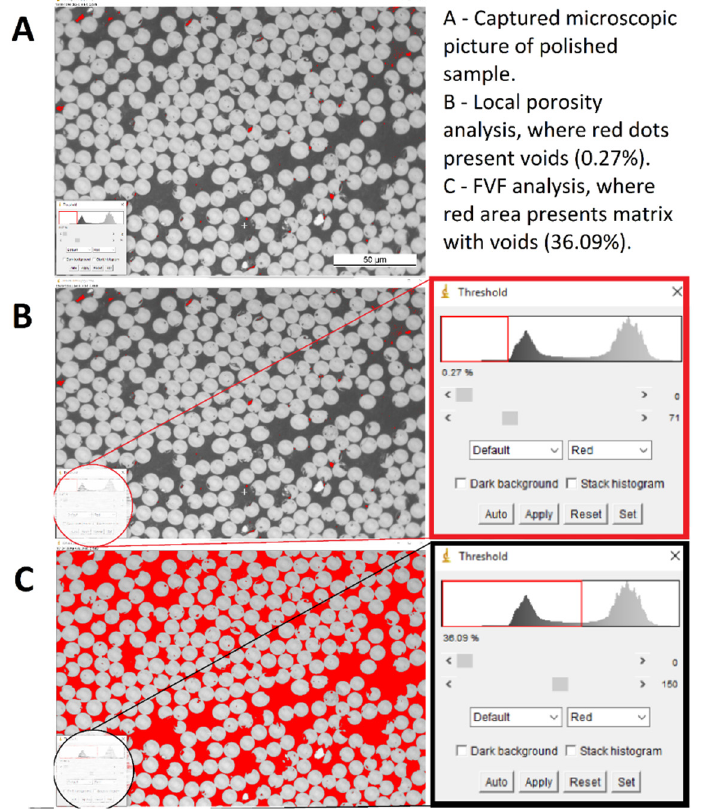
Figure 4. An example of determining local porosity and fibre volume fraction via optical microscopy. Light grey cross sections are AS4 carbon fibres and dark grey area is the PA12 matrix. Red spots in ( A , B ) are voids, while the red area in ( C ) represents the voids plus the PA12 matrix area.